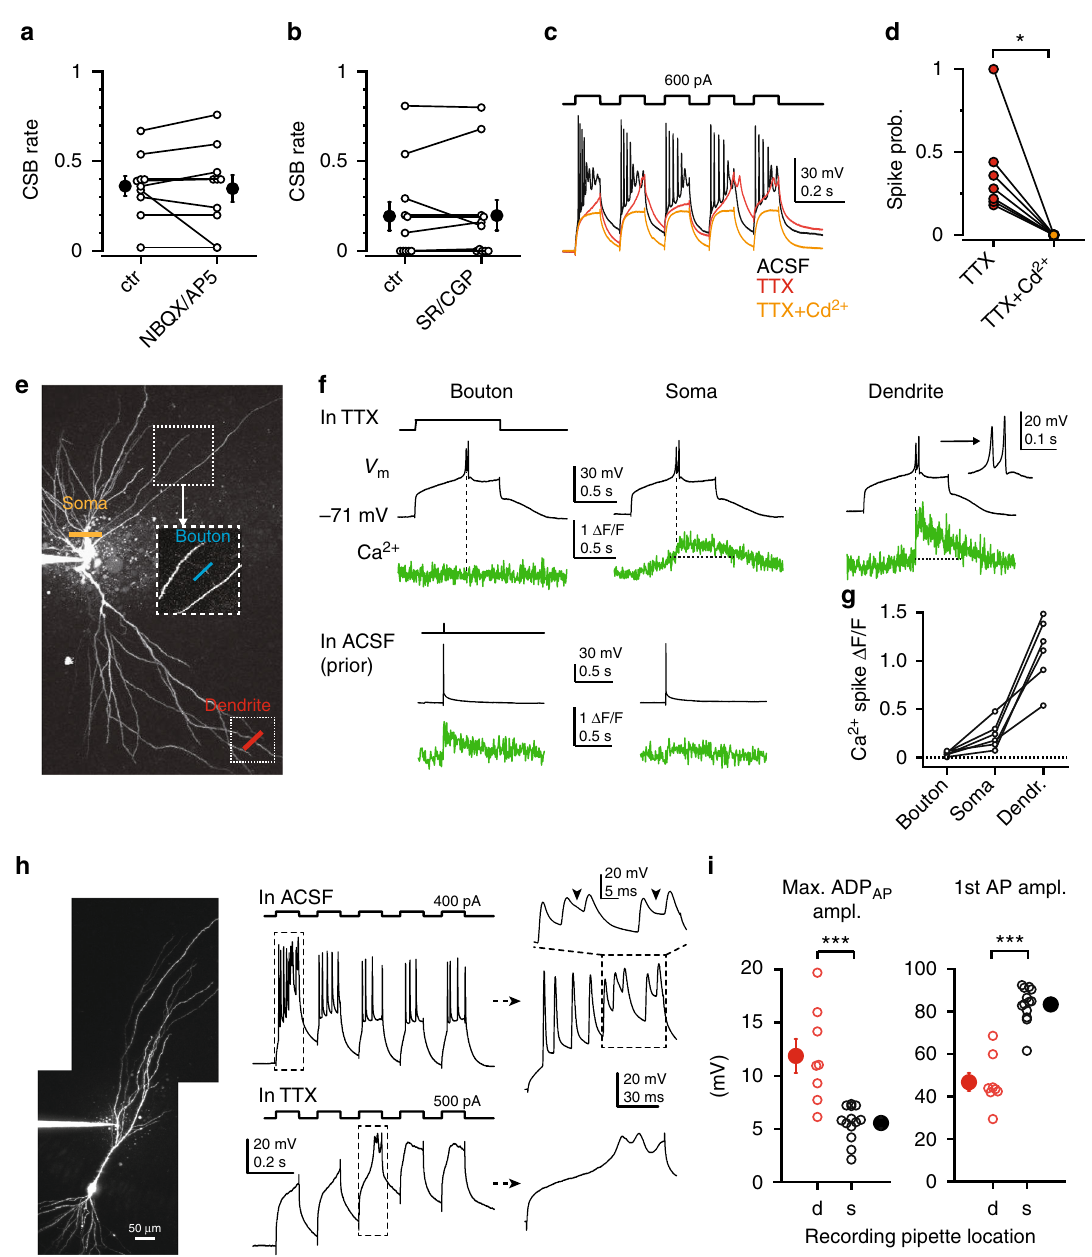
Fig. 3 CSBs are produced intrinsically by VGCC-mediated d-spikes. a Effect of AMPA/NMDA receptor inhibitors (10 μ M NBQX and 50 μ M D-AP5; tested on CSB cells) on CSB rate at the same I inj strength (300 or 600 pA). b Effect of GABA A /GABA B receptor inhibitors (2 μ M SR95531 and 2 μ M CGP55845) on CSB rate at the same I inj strength (300 or 600 pA). c Representative voltage responses of a CSB H cell under control conditions (black), in the presence of 1 μ M TTX (red), and after the subsequent addition of 200 μ M Cd 2 + (orange). Note the regenerative responses in TTX that are completely eliminated by Cd 2 + . d Summary of the effect of 100 – 200 μ M Cd 2 + on spikes in TTX. e Z-stack of a RS cell loaded with 100 μ M OGB-1 and 50 μ M Alexa 594. Subsequent somatic, dendritic and bouton imaging locations are indicated by lines. f Top, example voltage and Ca 2 + recordings from the locations in e . Voltage protocol shown on top, left. Inset shows the temporal details of the spike. Bottom: Ca 2 + responses were evoked by single action potentials in the bouton and soma prior to TTX washin. g Comparison of the spike-related Ca 2 + signal amplitude (using OGB-1) in bouton, soma and dendrite of the same neurons. h Left, z-stack of a CA3PC patched on the apical dendrite. Middle, voltage traces recorded from the dendrite in ACSF (top) and after TTX application (bottom) applying repetitive I inj protocol. Right, pulses magni fi ed from the dashed boxes in middle panels. Note the sustained depolarization (arrowheads) following some of the bAPs. i Maximal ADP AP amplitude (left) and amplitude of the fi rst AP (right) measured in dendritic (d) and somatic (s) recordings (in different experiments). Filled symbols and error bars represent mean ± s.e.m. * p < 0.05, *** p < 0.001. Source data are provided as a Source Data fi